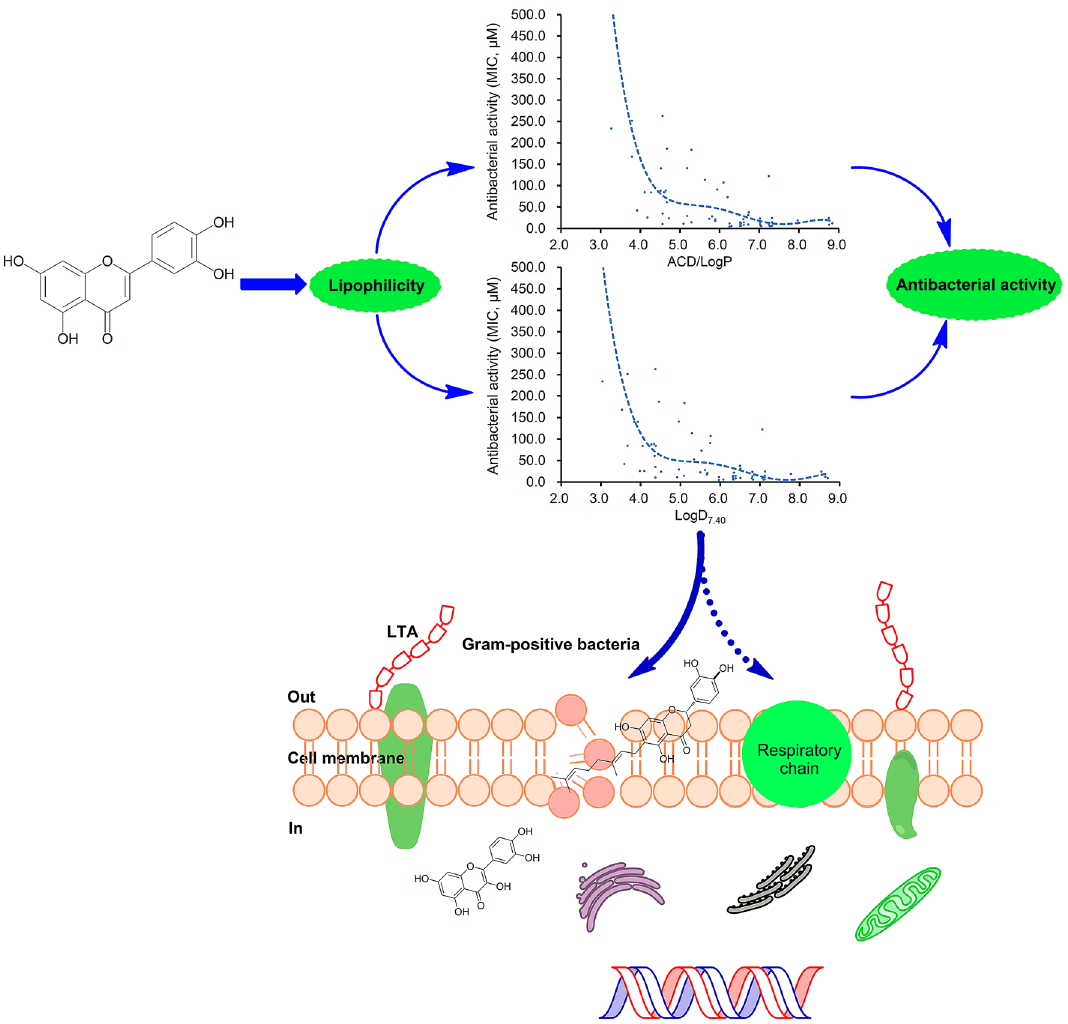
Figure 9. Diagrammatic presentation for the inhibitory activities and mechanisms of plant flavonoids to gram- positive